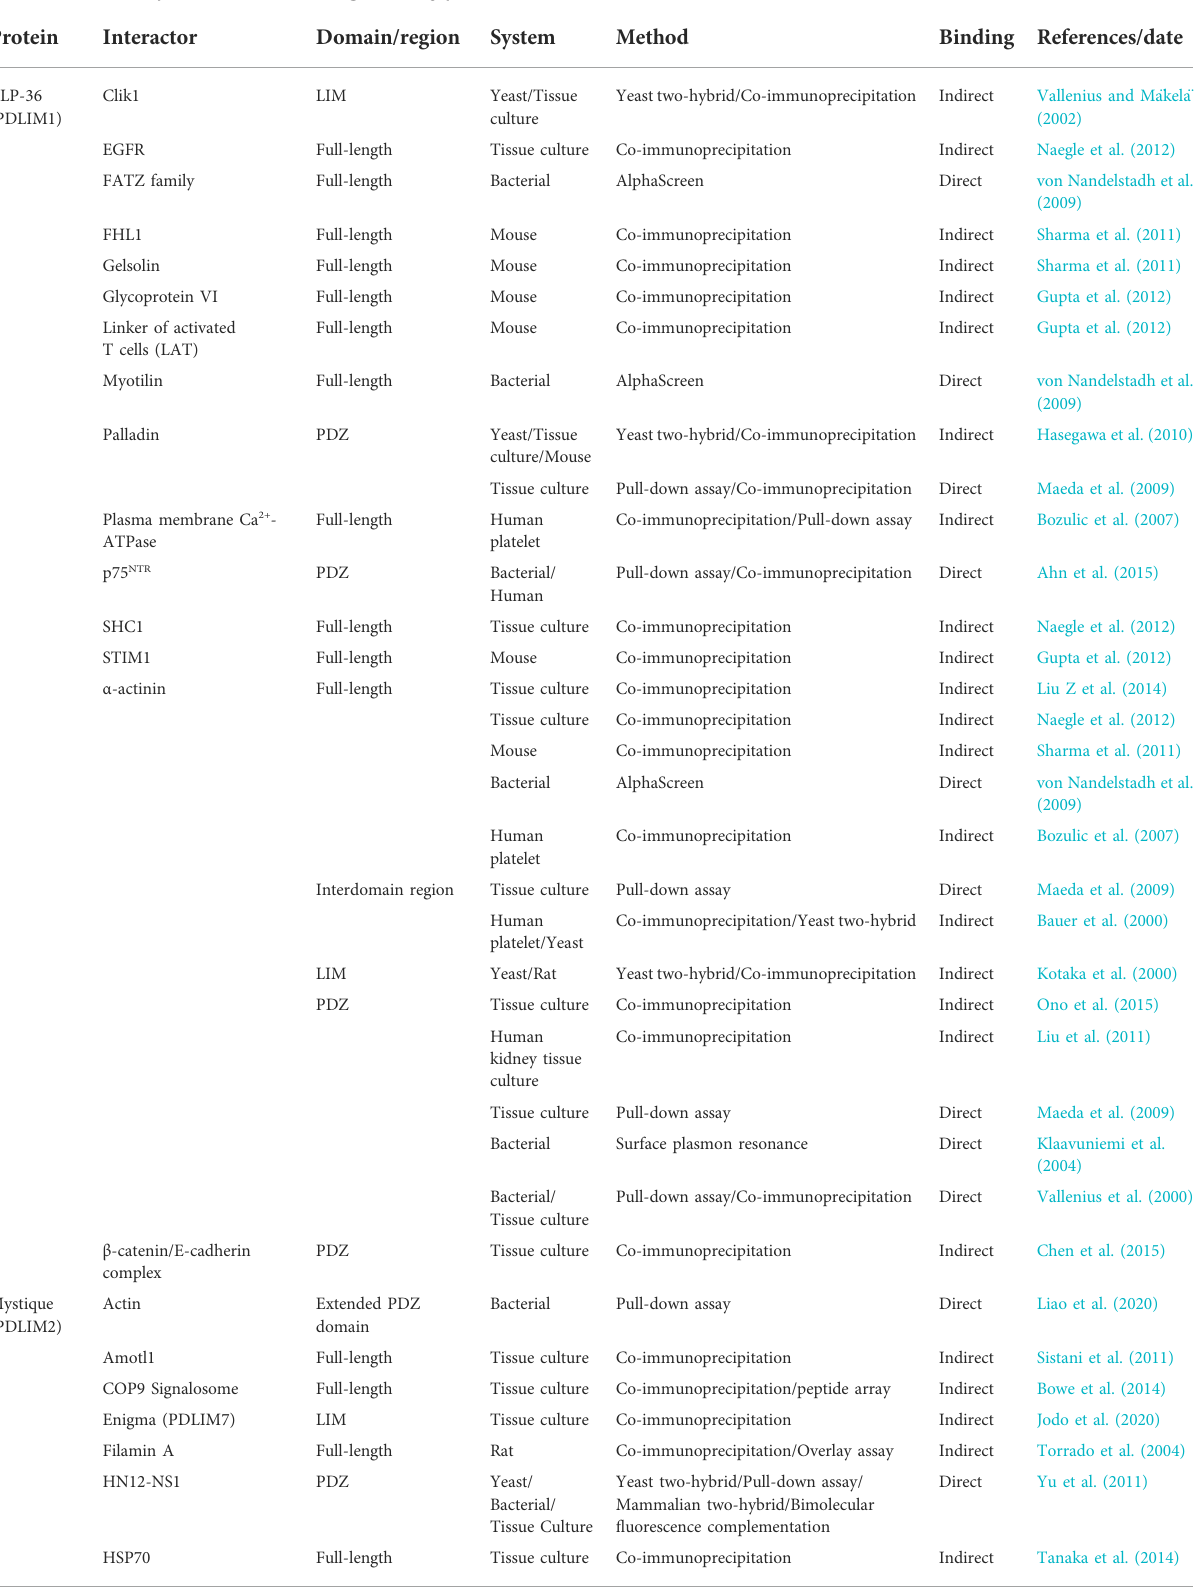
TABLE 1 Interaction partners of the ALP/Enigma family